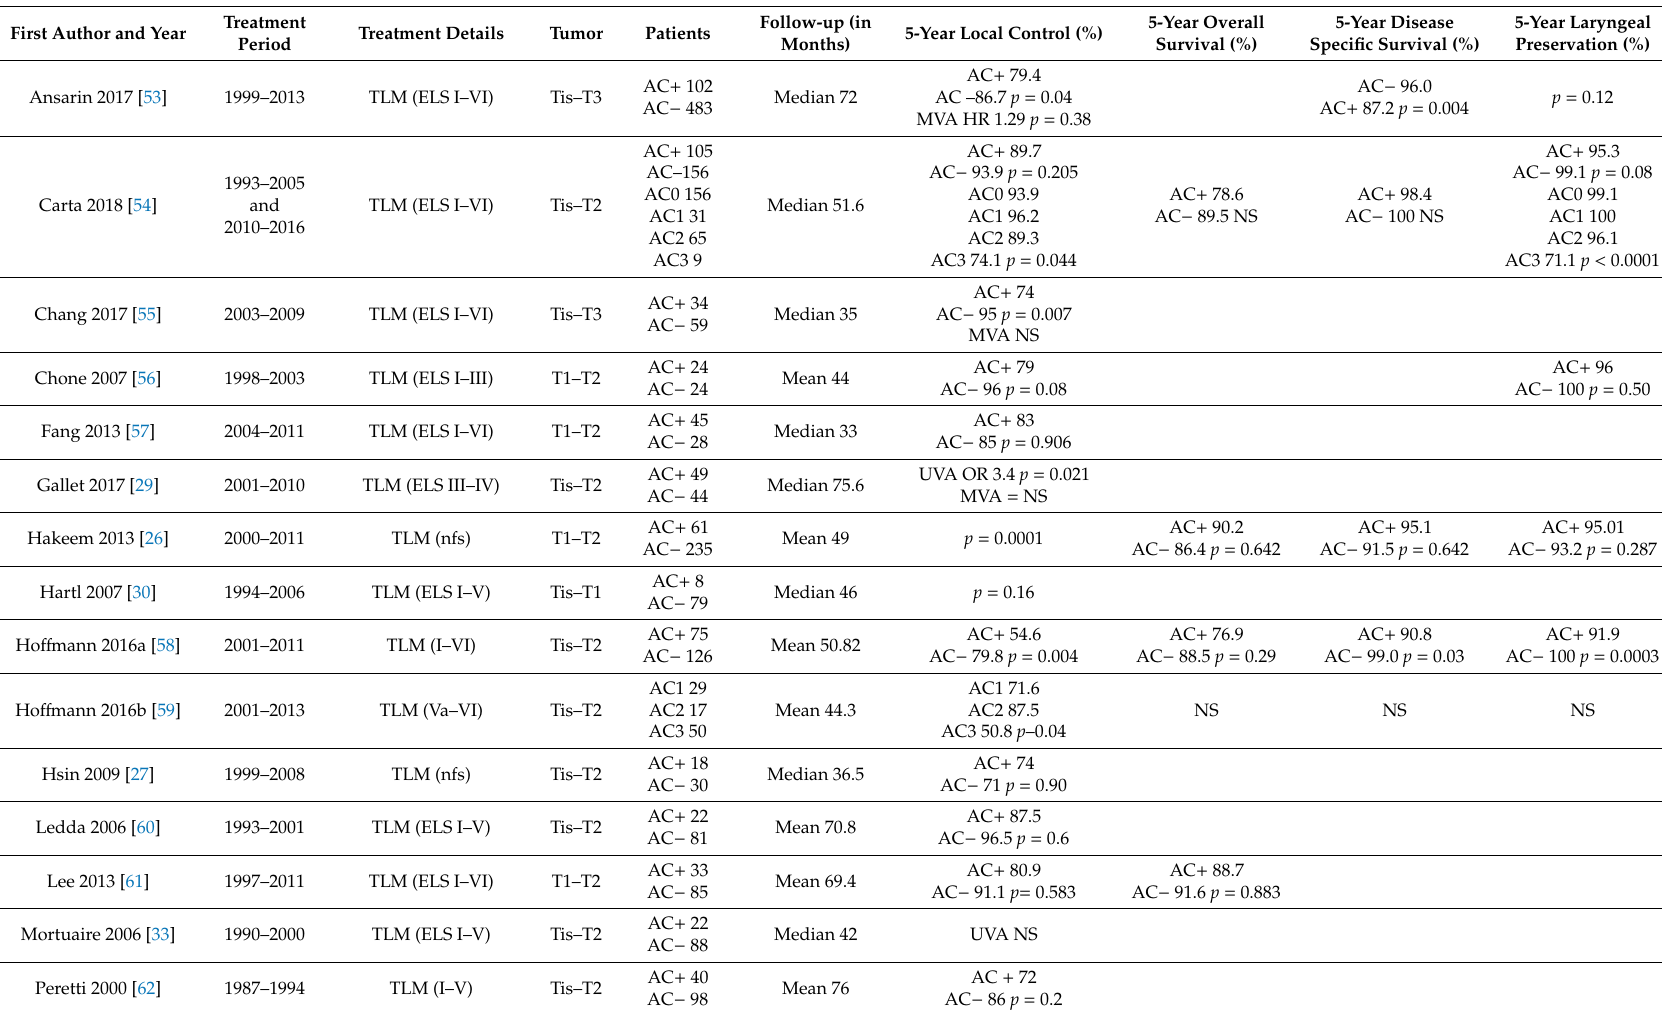
Table 2. Oncological Outcomes of Patients after Treatment with TLM for Involvement with or Without the